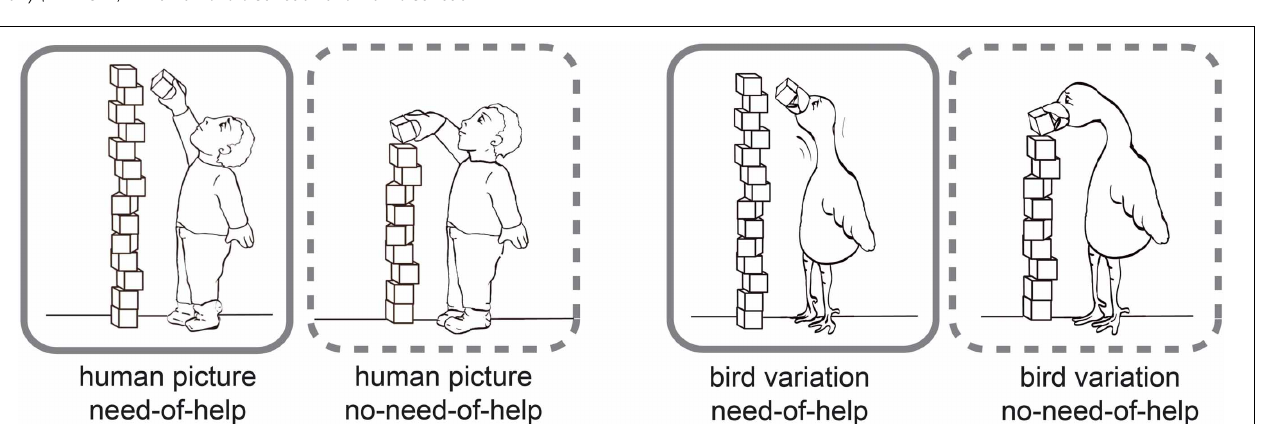
Pictures measured between 15.62 and 11.75 ◦ of visual angle on the different